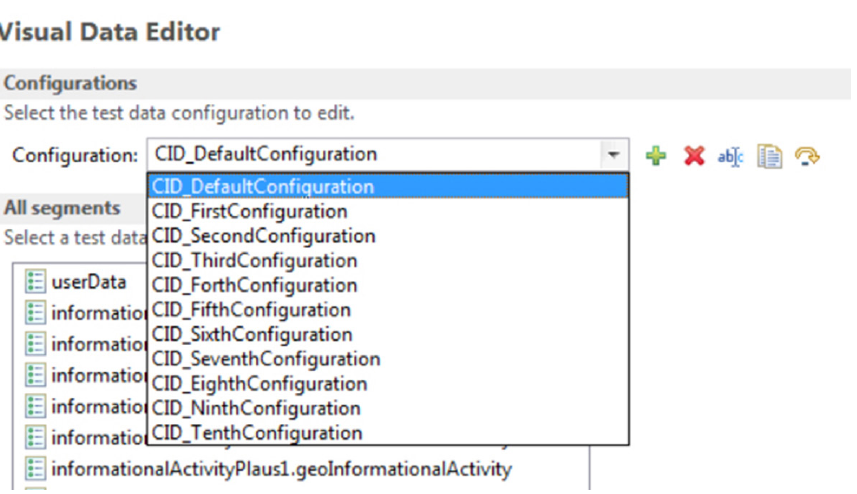
Fig. 4. The screen of the VDE in eclipse